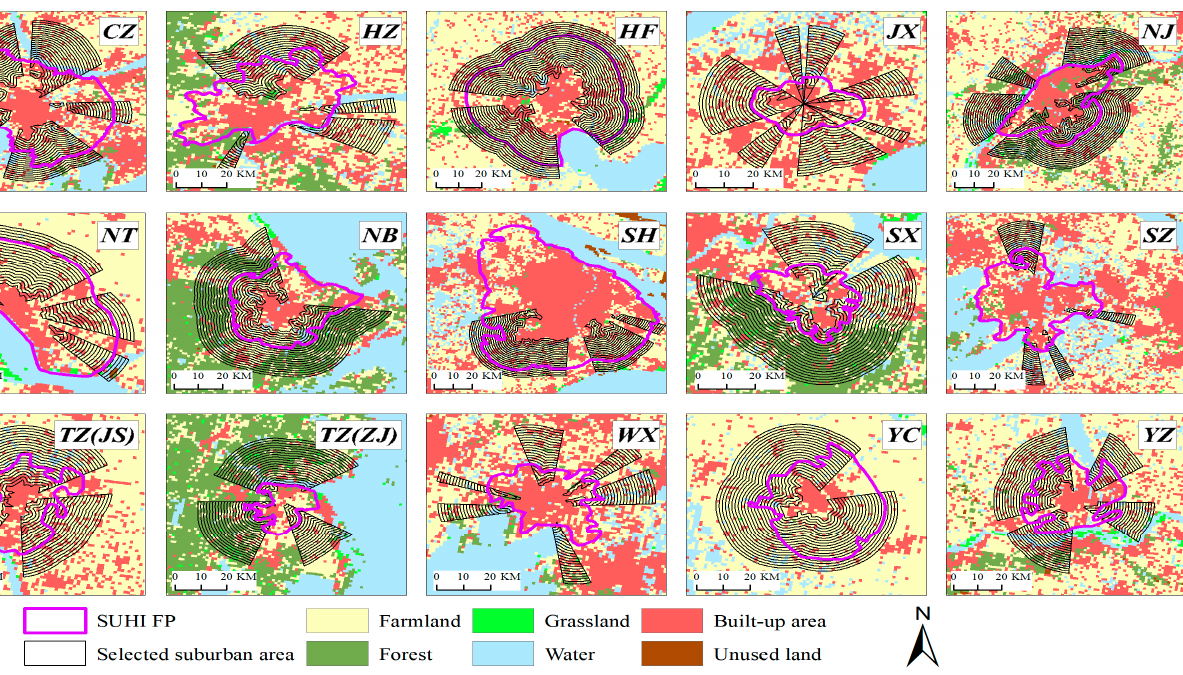
According to the d and T 0 , the final SUHI FPs of 15 cities were delineated (Figure 4).